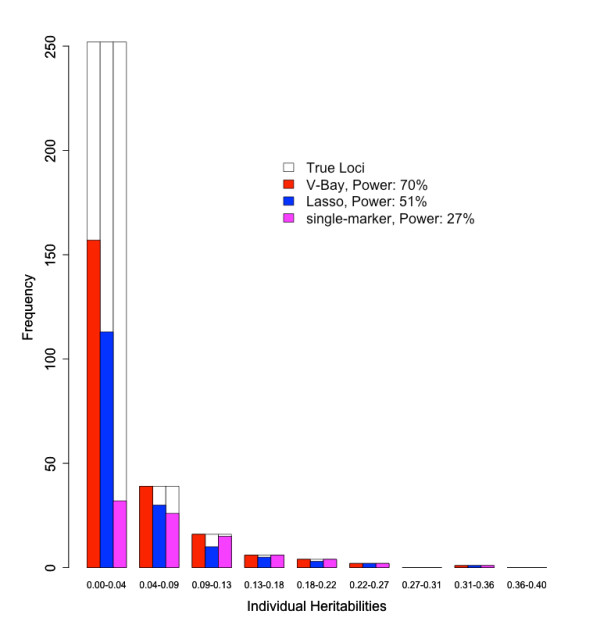
Histograms of loci identified by V-Bay, the lasso, and single-marker analysis as a function of individual heritability. The false-discovery rate is controlled to 0.0%. These graphs summarize the results of ten replicate simulated data-sets with 100,000 markers, 32 loci with associations, a sample size of 1000, and a total phenotype heritability of 0.9. The power for each method at 0.0% false-discovery rate is shown in the legend.